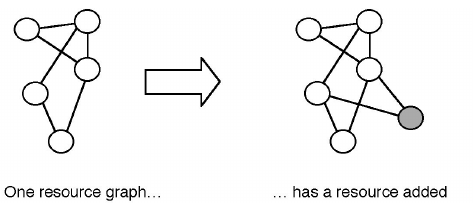
FIG. 4. Incremental change. A resource graph has a resource added (cid:1) or taken away, not represented